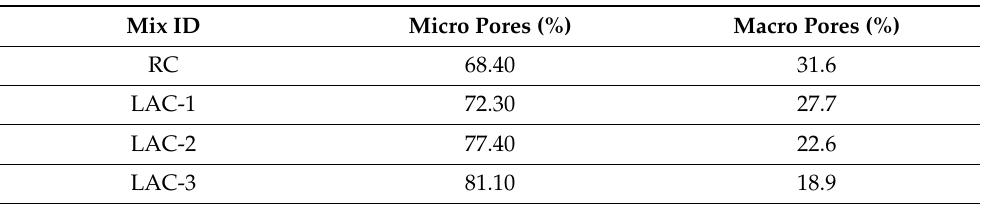
Table 4. The calculated percentage of the micro and macro pores.